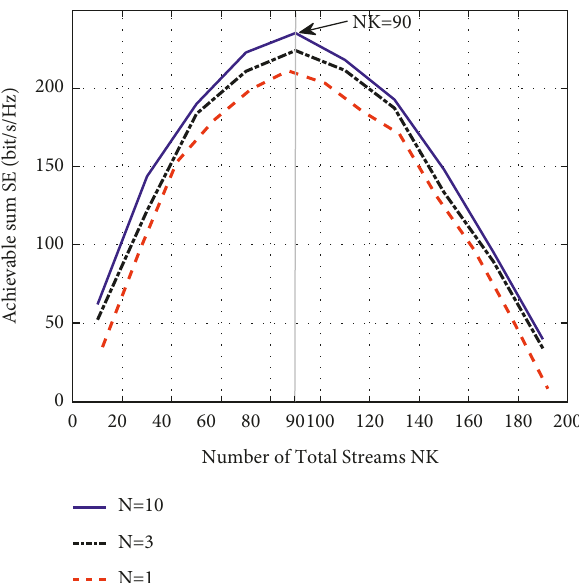
Figure 6: The total amount of SE can be obtained as a function of NK for N � 1,3,10 and M �